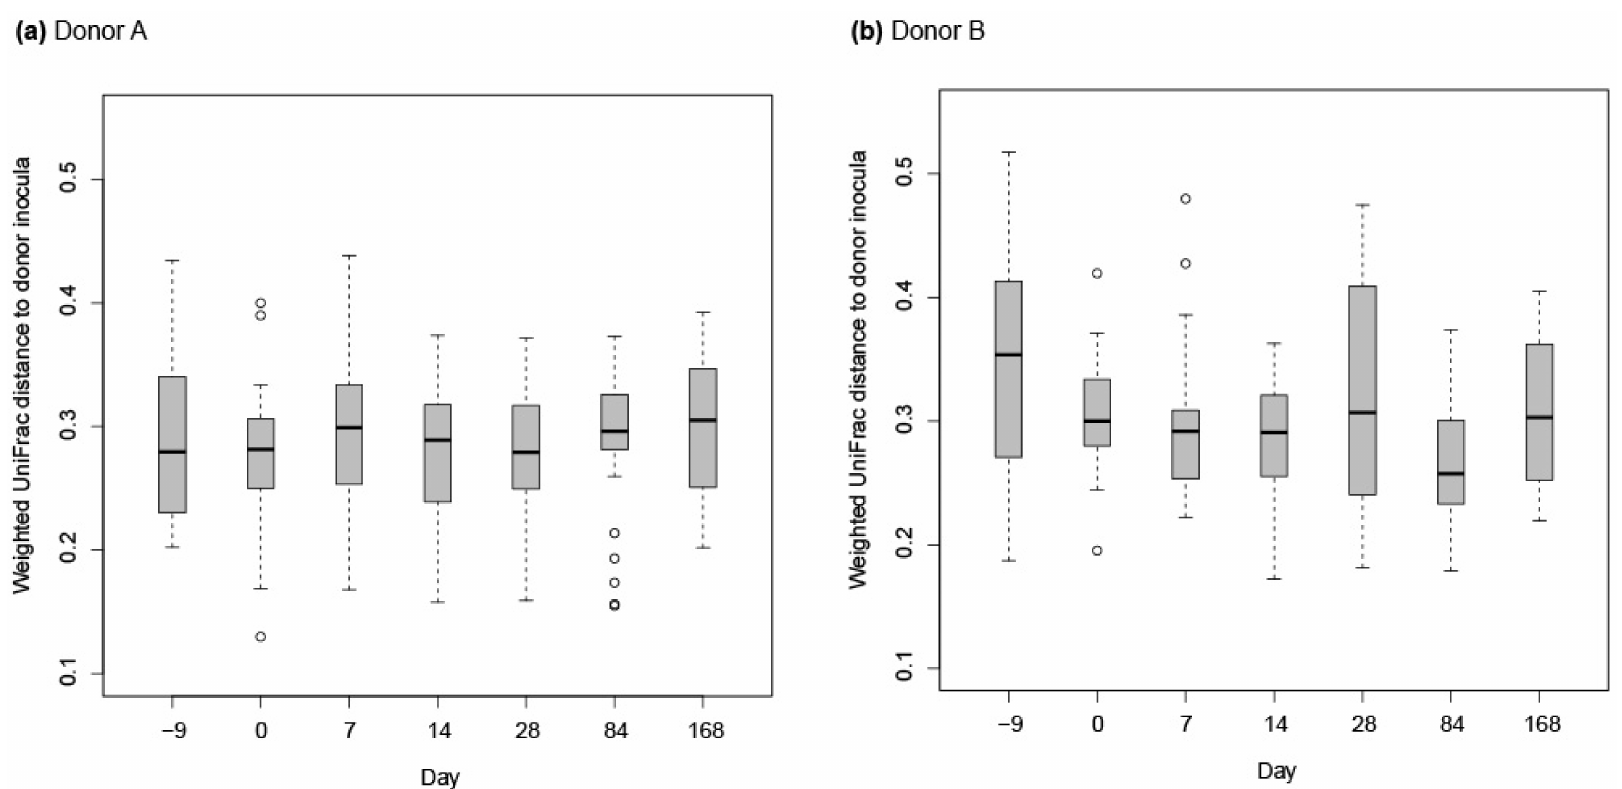
Figure 10. Boxplots are shown by donor animal (i.e., A or B) for the similarity of FFW horse faecal microbiota with the donor inocula over time using weighted UniFrac. All pairwise distances of a FFW horse faecal microbiota sample at one interval with all donor inoculant samples was used to generate the box plots (e.g., FFW horse faecal microbiota sample d –9 was compared with donor inoculant samples D-4, D-3, D-2, D-1, D0; FFW horse faecal microbiota sample d0 was then compared with donor inoculant samples D-4, D-3, D-2, D-1, D0 etc.). Boxes show the 25th and 75th percentiles with the median represented by a horizontal line. Whiskers show the data range with the exception of outliers that are indicated by data